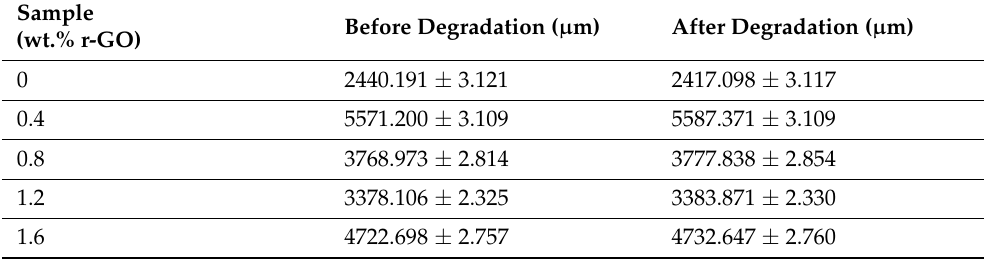
Table 3. The comparison means pore size of hydrogel Alginate/PVA/r-GO before and after 28 days of immersion.